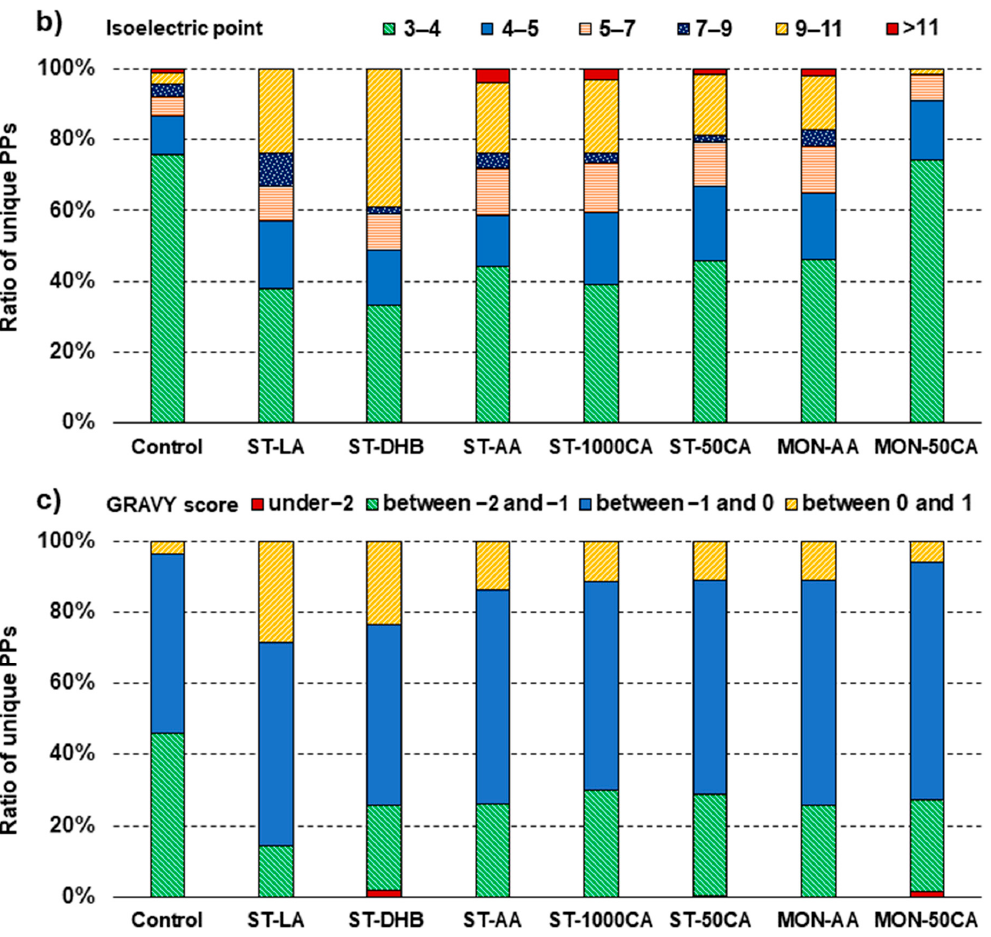
Figure 2. Selectivity regarding backbone characteristics of identified PPs. Relative distributions of unique PPs of ( a ) given peptide length (number of amino acids per peptide), ( b ) pI range, ( c ) GRAVY score range. For each method, the results of 5 parallel enrichments were combined.